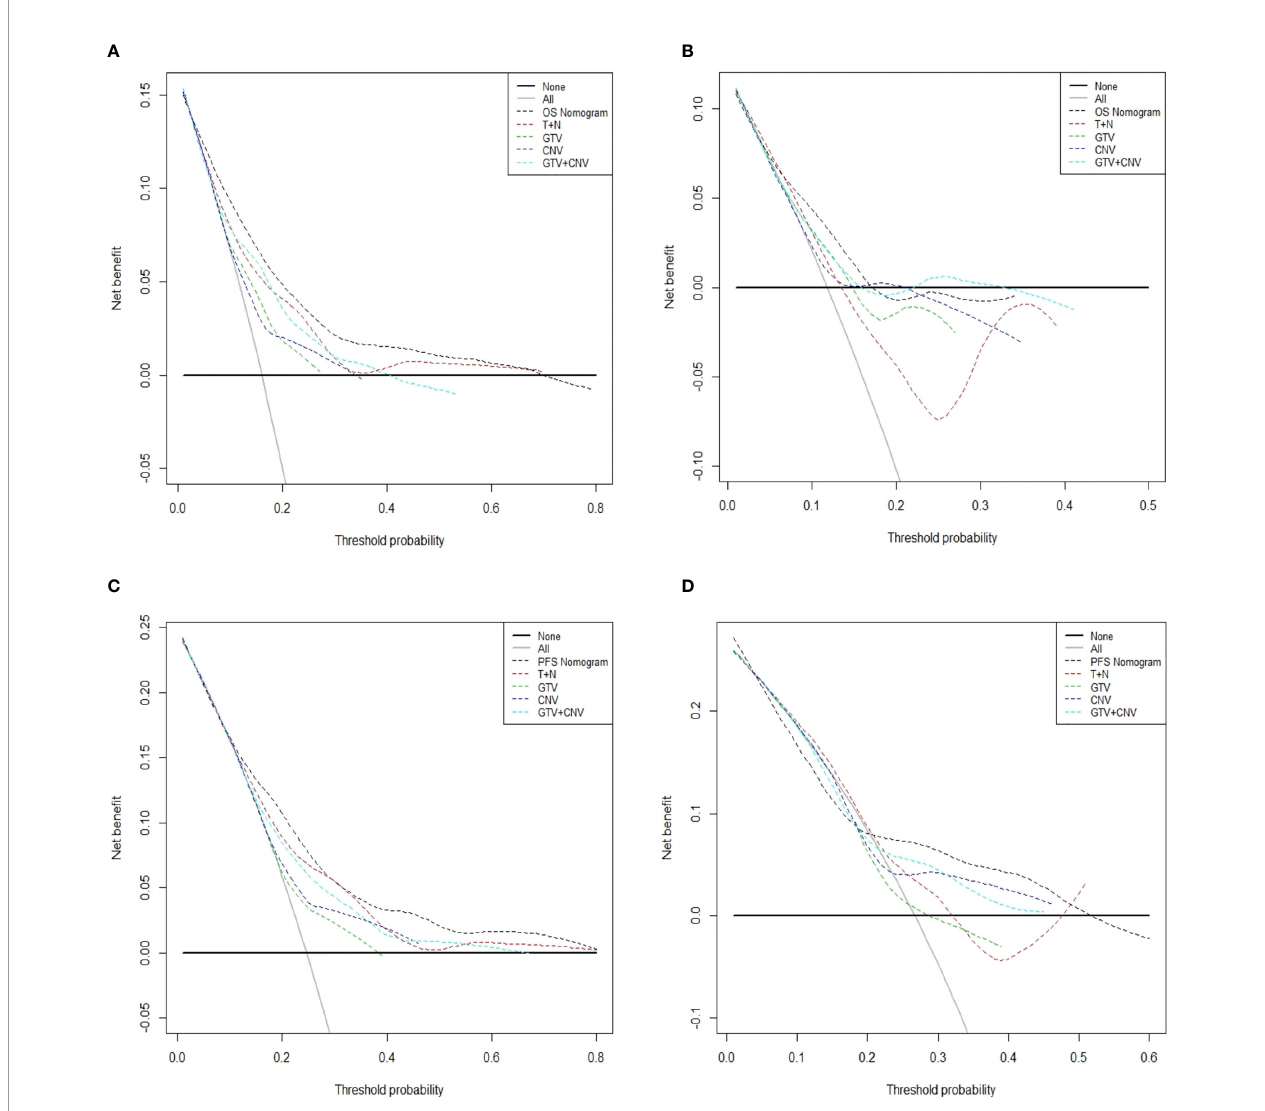
FIGURE 5 | Decision curve analysis for the predicted-nomogram model of 5-year OS in the training (A) and validation (B) sets. Decision curve analysis for the predicted-nomogram model of 5-year PFS in the training (C) and validation (D) sets. OS, overall survival; PFS, progression-free survival; T, T stage; N, N stage; GTV, gross tumor volume; CNV, cervical nodal